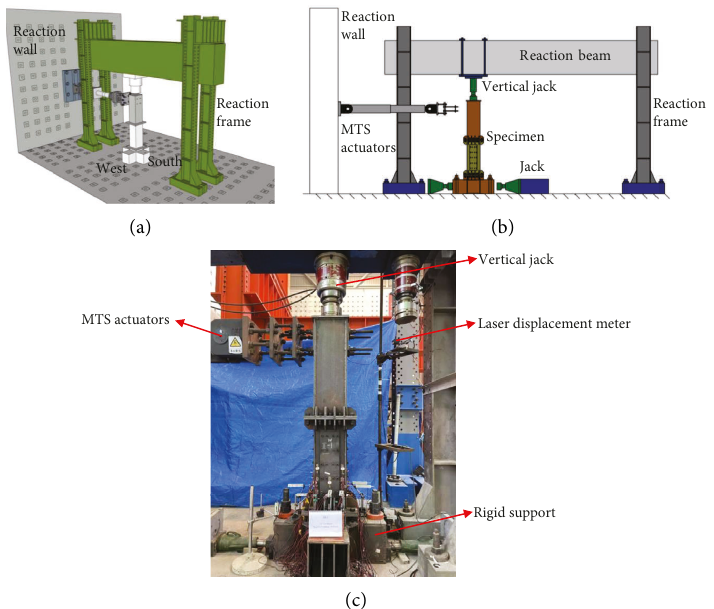
Figure 3: Test setup. (a) Three-dimensional diagram. (b) Elevation diagram. (c) Photograph of test.